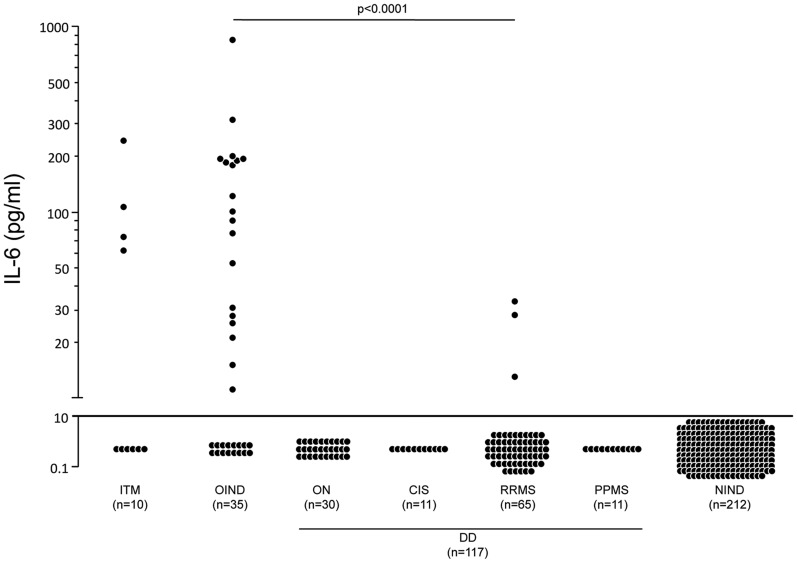
Distribution of CSF IL-6 levels in patient subgroups.The CSF IL-6 levels of all individual patients were measured using quantitative ELISA. Data are expressed as pg/ml and represented on a logarithmic scale. Only significant p-values are shown in the graph (p<0.001; Kruskal–Wallis test). The horizontal line shows the estimated optimal cut-off values for CSF IL-6 levels (10 pg/ml). ITM, idiopathic transverse myelitis; OIND, other inflammatory neurological diseases; ON, optic neuritis; CIS, clinically isolated syndrome; RRMS, relapsing-remitting multiple sclerosis; PPMS, primary progressive multiple sclerosis; NIND, non-inflammatory neurological diseases; DD, demyelinating diseases.